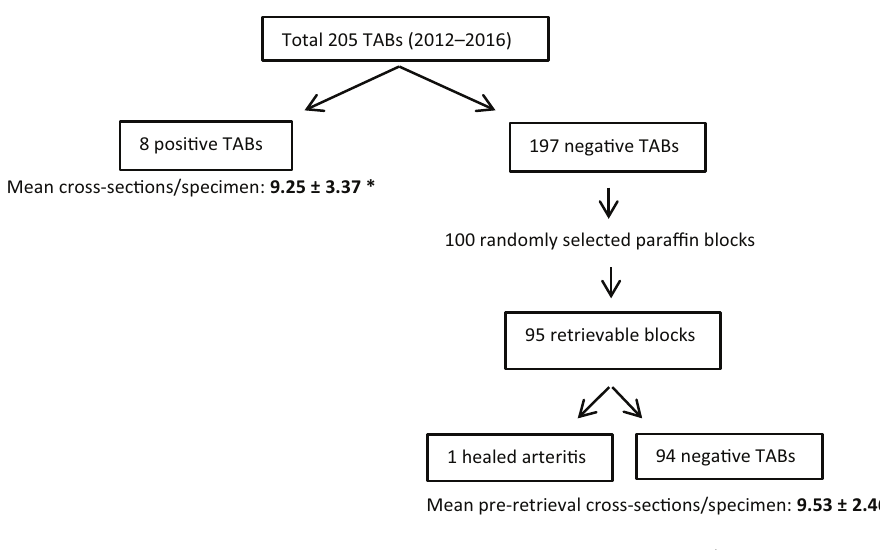
Mean pre-retrieval cross-sec!ons/specimen: 9.53 ± 2.46 * Mean post-retrieval cross-sec!ons/specimen: 8.12 ± 3.09 Total pre- and post-retrieval cross-sec!ons/specimen: 17.66 ± 4.43 Figure 2. Summary of the methods and main outcomes of the study. *There was no significant difference in the mean number of cross-sections per specimen between the positive- and original negative-TABs ( P = 0.990). Based on the comparison of these two items, 9.87 ± 2.77 (95% confidence intervals) cross-sections per specimen were considered sufficient for precise